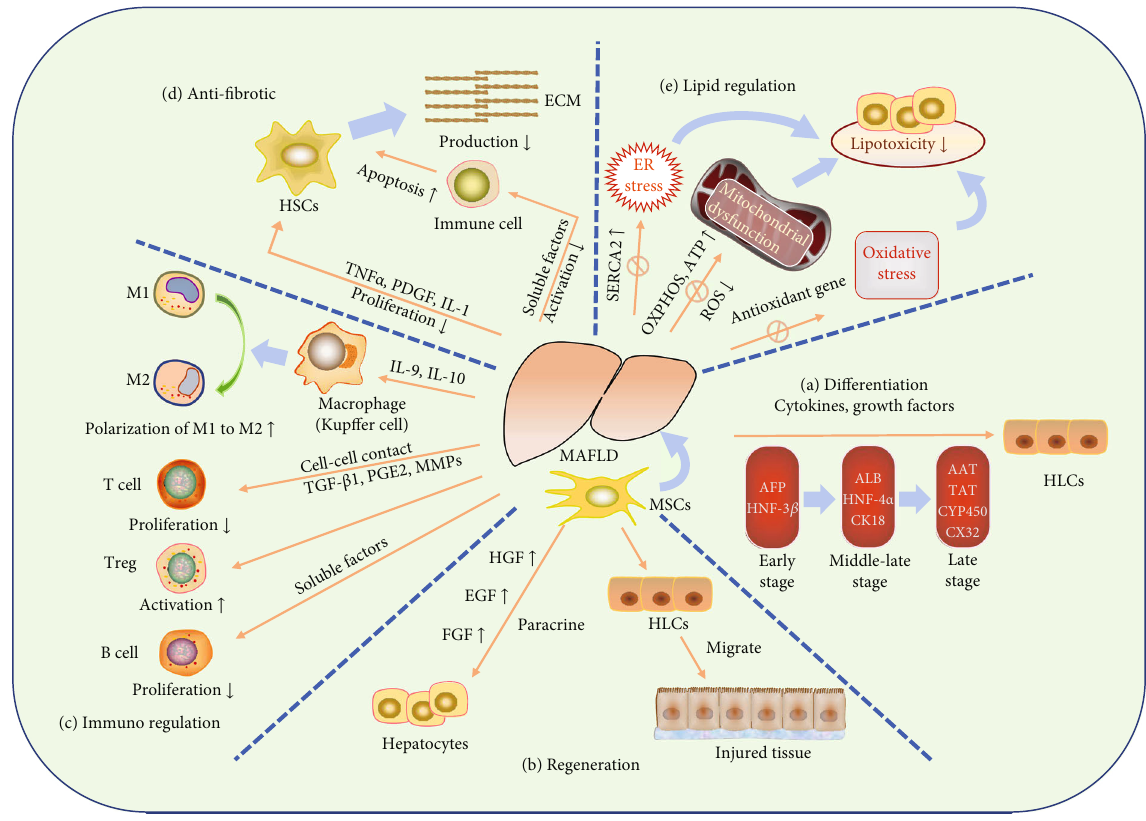
Figure 1: Mechanisms of MSCs in MAFLD. (a) MSCs can di ff erentiate into HLCs under the actions of cytokines and growth factors. (b) MSCs can promote liver tissue regeneration. (c) MSCs regulate the corresponding e ff ector cells of innate and adaptive immune response. (d) The anti fi brosis e ff ect of MSCs can be divided into direct and indirect e ff ects on HSCs. (e) MSCs reduce lipid toxicity by regulating lipid metabolism. MSCs: mesenchymal stem cells; HLCs: hepatocyte-like cells; AFP: alpha fetoprotein; HNF-3 β : hepatocyte nuclear factor-3 β ; ALB: albumin; HNF-4 α : hepatocyte nuclear factor-4 α ; CK18: cytokeratin 18; AAT: α 1-antitrypsin; TAT: tyrosine aminotransferase; CYP50: cytochrome P450; CX32: connexin 32; HGF: hepatocyte growth factor; EGF: epidermal growth factor; FGF: fi broblast growth factor; IL-9: interleukin-9; IL-10: interleukin-10; TGF- β 1: transforming growth factor- β 1; PGE2: prostaglandin E2; MMPs: matrix metalloproteinases; TNF- α : tumor necrosis factor- α ; PDGF: platelet-derived growth factor; IL-1: interleukin-1; HSCs: hepatic stellate cells; ECM: extracellular matrix; SERCA2: sarcoplasmic reticulum Ca(2+) ATPase; ROS: reactive oxygen